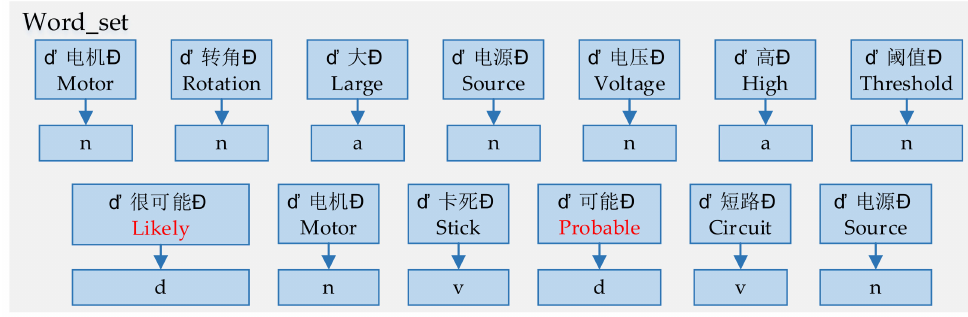
Figure 4. The base word set O ( o ) . Thirdly, the basic words are combined according to X ( x ) and F ( D ) to obtain the at‑ tribute phrase and the fault cause phrase, as shown in Figure 5.